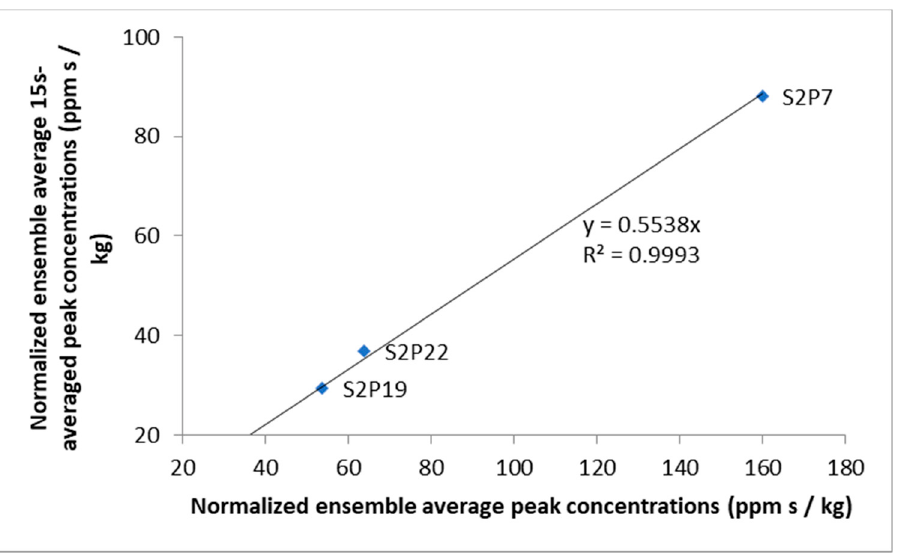
Figure 7. Puff releases: ensemble average ( m ) values of time-averaged ( ∆ τ = 15 s ) peak concentrations vs. measured peak concentrations ( ∆ τ 0 = 0.666 s ).